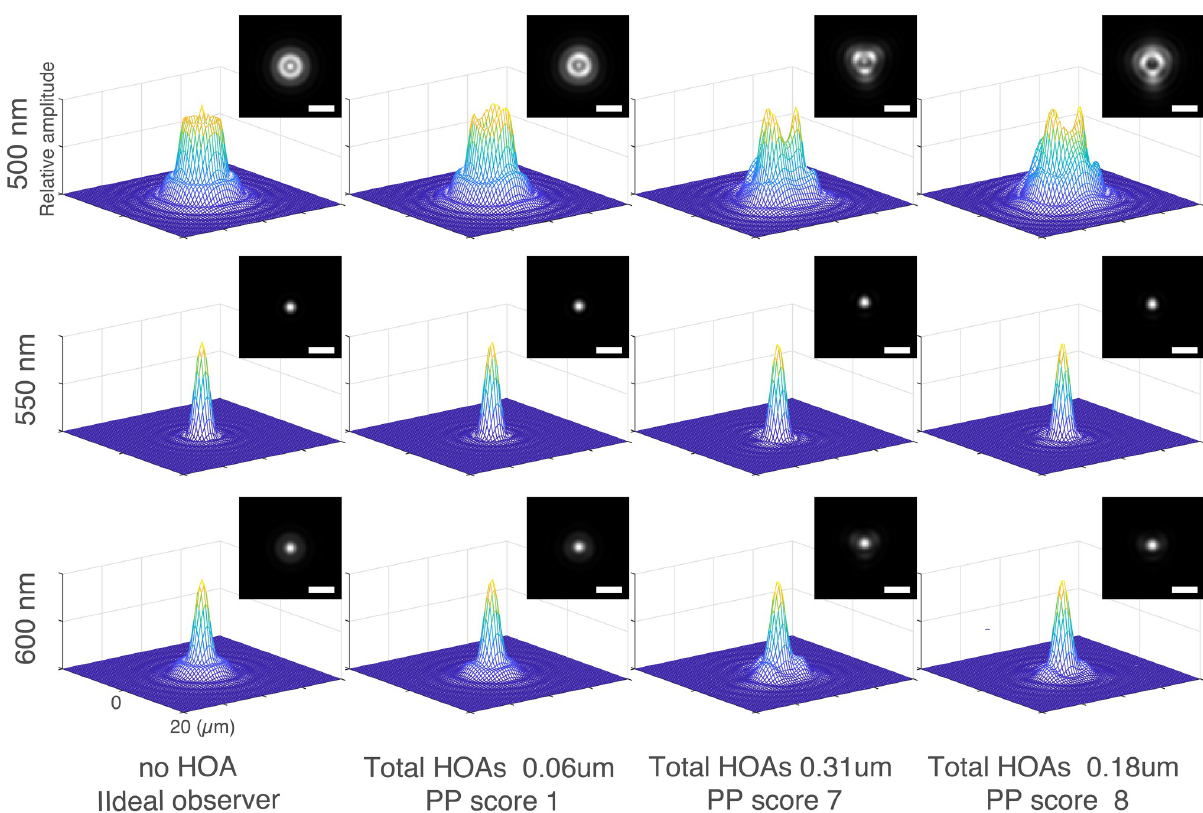
Fig 4. Point spread function from HOAs of ideal observer and representative patients. The PSFs of the ideal observer (the left column, no HOAs) and representative patients in this study are estimated with 3mm diameter pupil from higher-order aberrations at 500 nm (top row), 550 nm (middle row), and 600 nm (bottom row), respectively. All PSFs are normalized to the peak of each amplitude. The upper right inlet shows 2D image of each PSF. The scale bar is 10 μ